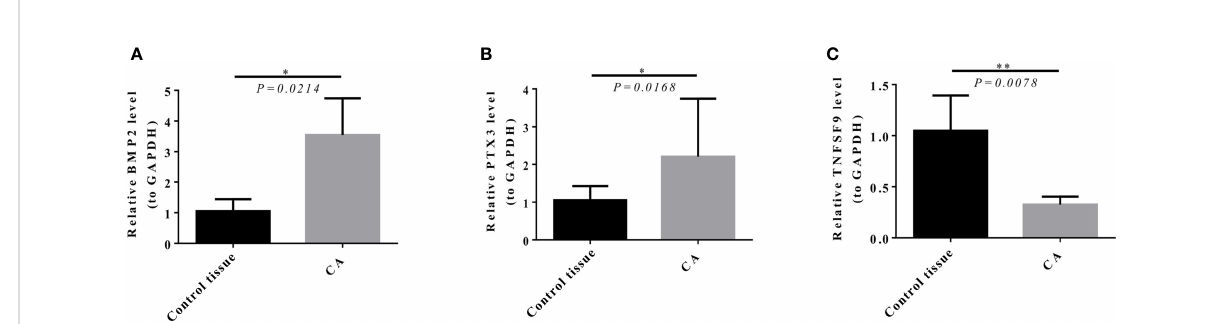
FIGURE 13 Expression level of model genes in target tissues veri fi ed by qRT-PCR (the average value of three repeated experiments). (A, B) BMP2 ( P = 0.0214) and PTX3 ( P = 0.0168) expression in GBM was signi fi cantly higher than that in control tissue. (C) TNFSF9 ( P = 0.0078) expression in GBM was signi fi cantly lower than that in control